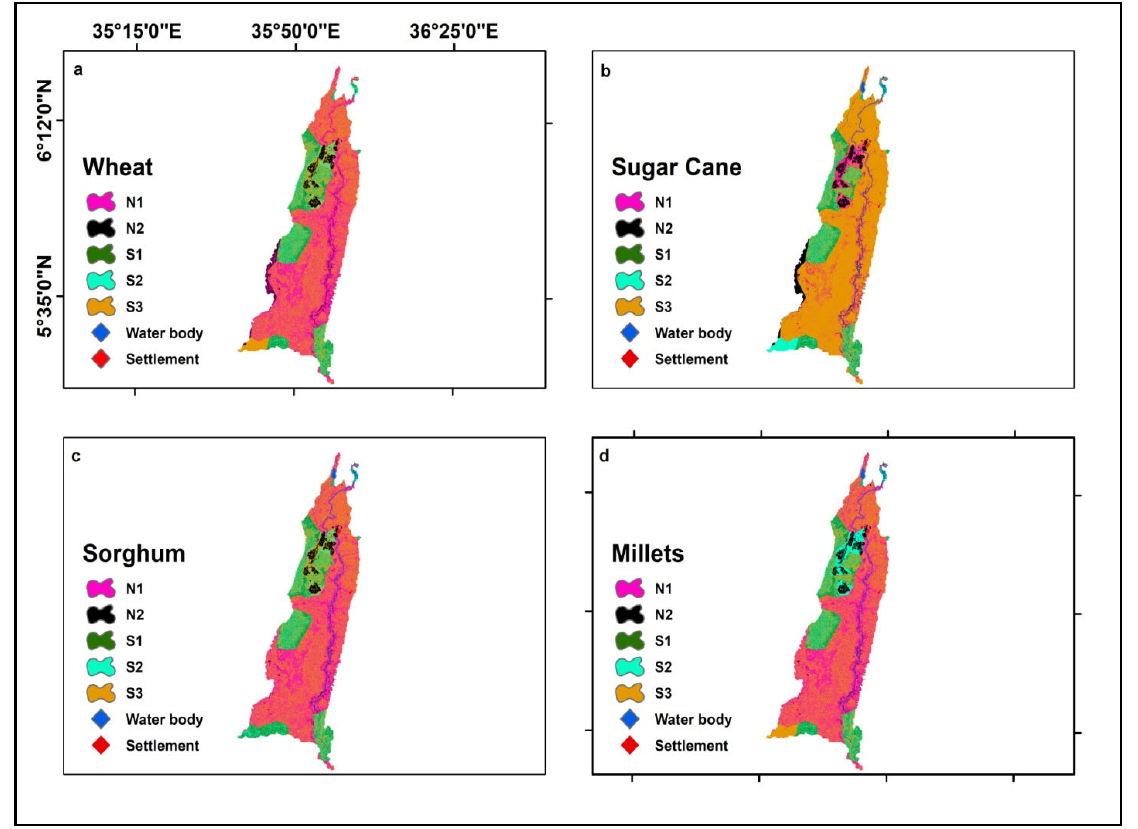
Figure 6. Land suitability map classes for ( a ) Wheat, ( b ) Sugarcane, ( c ) Sorghum, and, ( d ) Millets. Land series coded 4, 17, and 18 (1009.4 km 2 , 39.9%) show marginal suitability for all crops, Series coded 7 and 19 (760.6 km 2 , 30.1%) show marginal suitability for sugarcane only, and Land series coded 4, 8, 17, and 18 (1063.3 km 2 , 42.2%) show marginal suitability for wheat and sorghum. Land series coded 4, 14, 16, 17, and 18 covering (1041.9 km 2 , 41.2%) are marginally suitable for wheat and millets. Similarly, land series coded 4, 10, 17, and 18 (1026.9 km 2 , 40.6%) demonstrate marginal suitability for sorghum and millets. Land series coded 20 (153.2 km 2 , 6.1%) exhibits low suitability (not suitable for all crops currently). Land series coded 10 (17.6 km 2 , 0.7%) exhibits low suitability (currently unsuit ‐ able) for wheat only. Land in series coded 8 (53.8 km 2 , 2.1%) shows low suitability (cur ‐ rently unsuitable) only for sugarcane. In addition, land series coded 11, 19, and 20, which cover (909.9 km 2 , 35.9%), exhibit low suitability (currently not suitable) for sorghum and millets, and Land series coded 19 and 20 (886.8 km 2 , 35.1%) exhibit low suitability (currently not suitable) for wheat, sorghum, and millets. Finally, land series coded 9 and 21 (86.9 km 2 , 3.4%) are permanently unsuitable for all crops (Figure 7). Land series coded 10 (17.6 km 2 , 0.7%) is permanently unsuitable for all crops, and land series coded 9, 11, and 21 (110.0 km 2 , 4.4%) are permanently unsuitable for wheat and sugarcane (Tables 5 and 6).